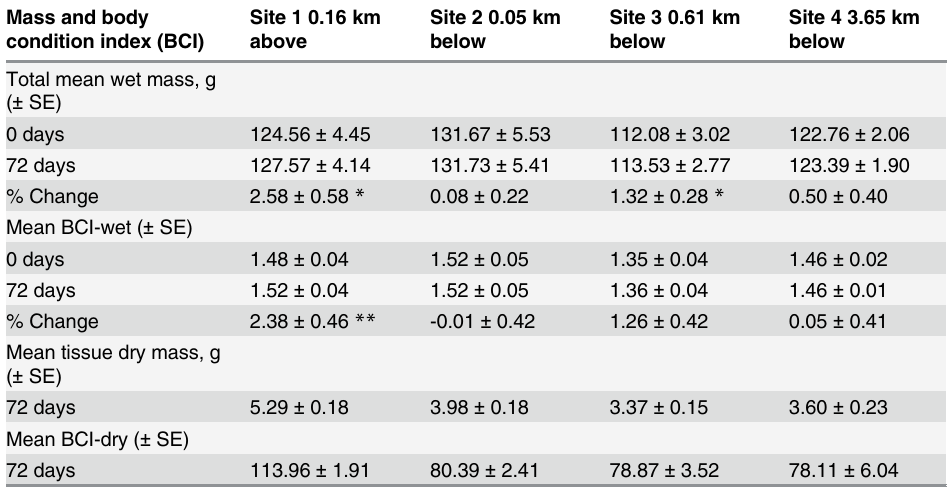
Mean tissue dry mass and mean BCI-dry values were only measured at day 72. Signi fi cant results of t-tests comparing pre- and post-exposure data indicated by asterisks: * Indicates p-value of < 0.05. ** indicates p-value of < 0.01.